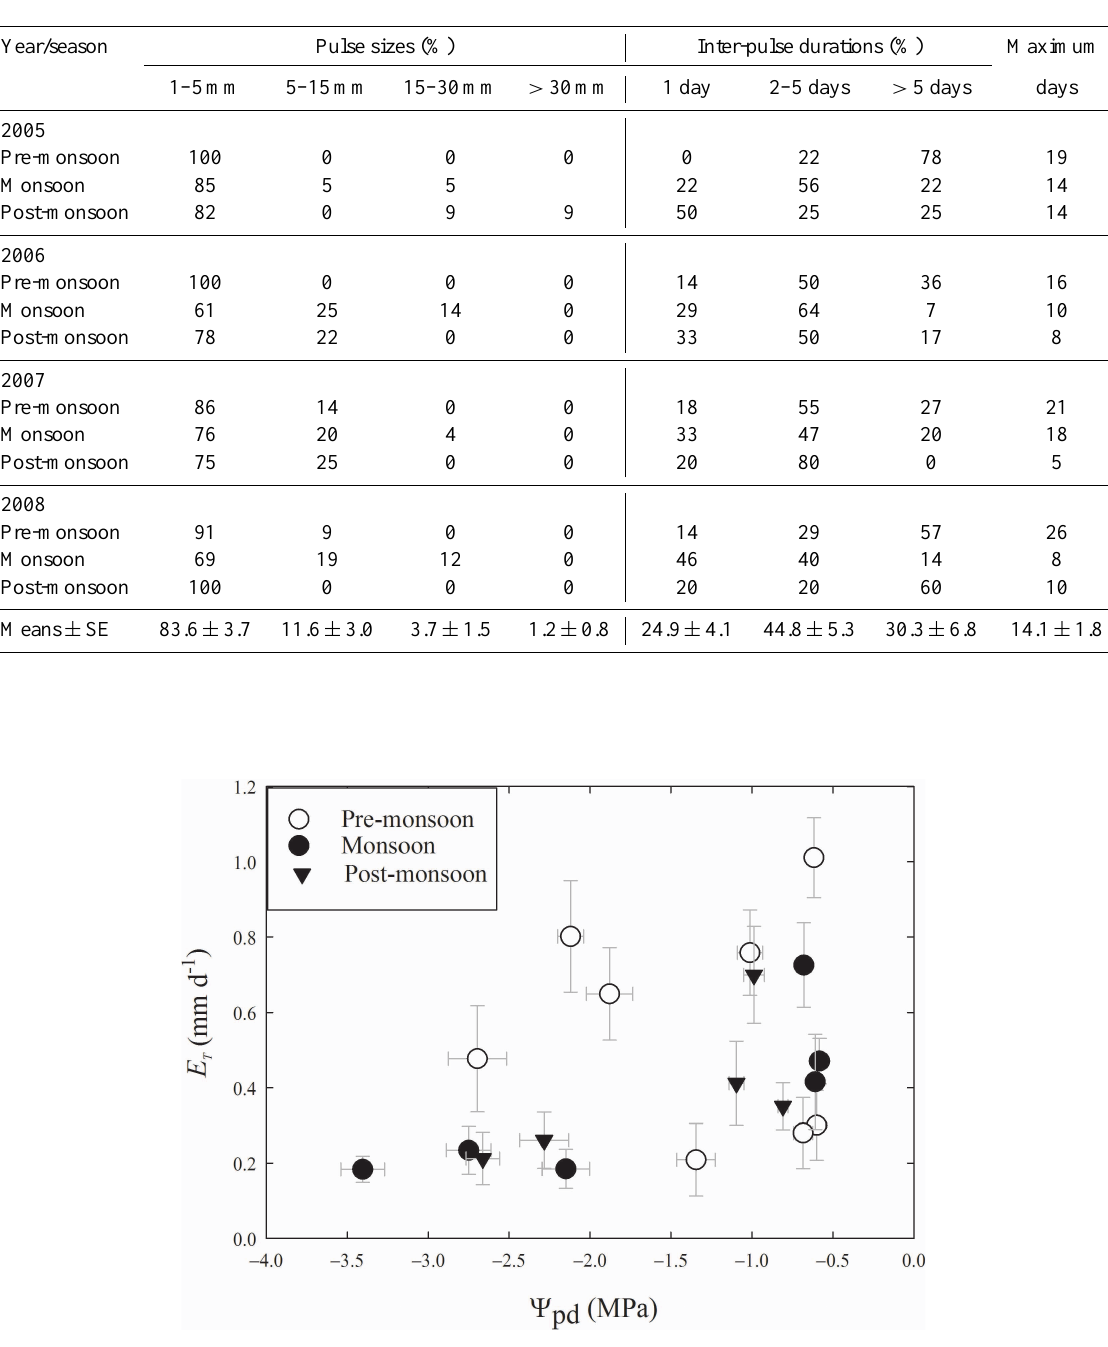
Table A1. Seasonal rain pulse sizes and inter-pulse duration shown as the percentage of events and durations, respectively. The numbers within parentheses are the number of rain events. The maximum days column shows the maximum number of days between pulse events.